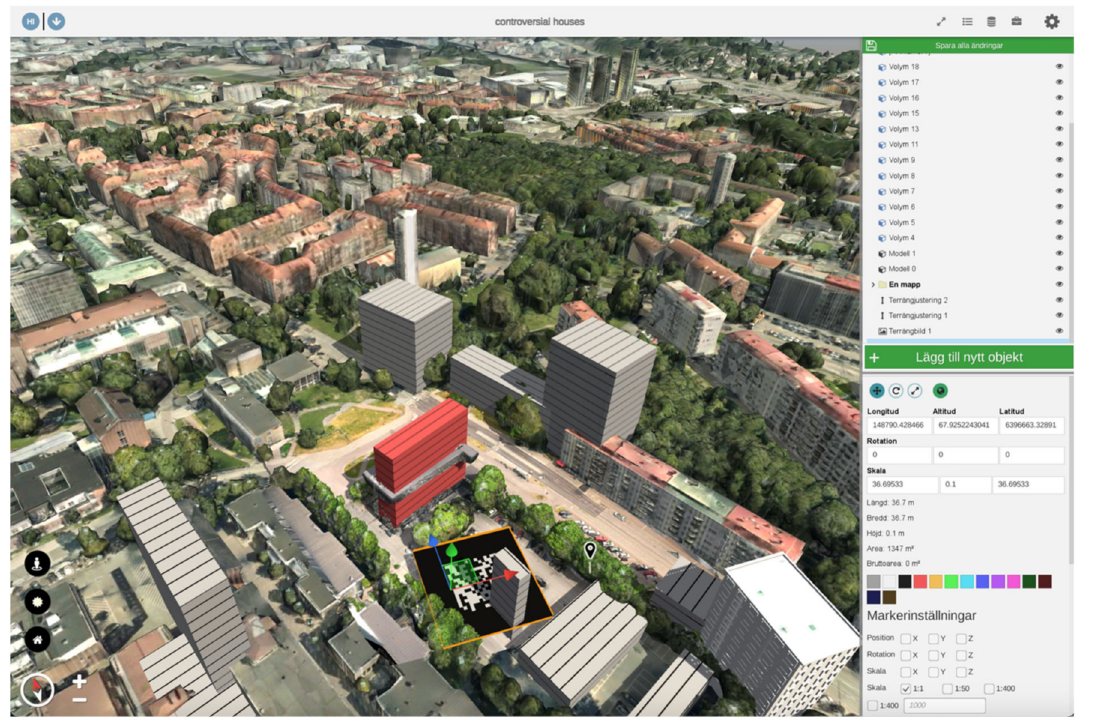
Figure 11. Using AR Markers when placing objects, allowing users to set the scale of projection and the size of the physical marker.